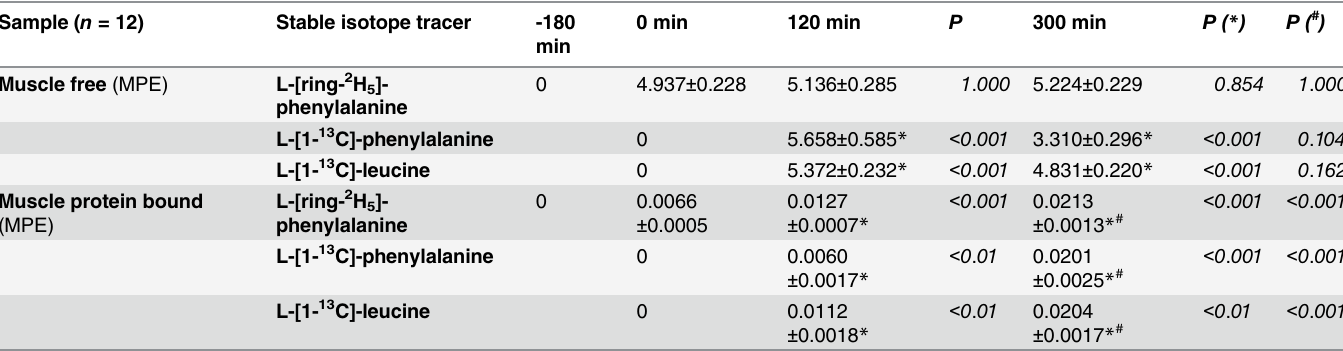
Table 3. Muscle tissue-free and muscle protein bound